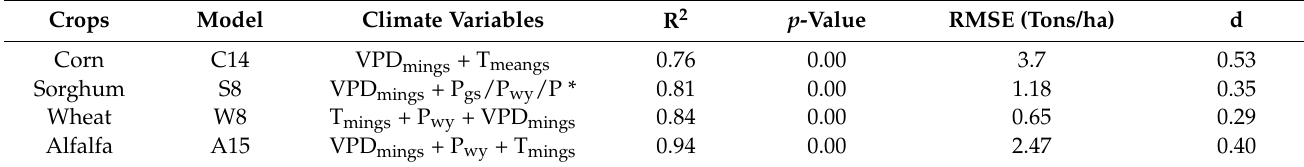
Figure 5. A summary of the correlation matrix for all 13 variables initially evaluated to predict ( a ) corn, ( b ) sorghum, ( c ) wheat, and ( d ) alfalfa yields. The matrices show the values of the Pearson’s correlation coefficient (R) with the direction and strength of correlation between all climate variables, with the positive values in blue, negative in red, − 0.25 to 0.25 in light shades of color. The correlation coefficients range from − 1 to 1, whereby − 1 means a perfect negative linear relationship between climate variables, 1 indicates a perfect positive linear relationship between variables, and 0 indicates that there is no relationship between climate variables. Color intensity is proportional to correlation coefficients. The variables on the top of each matrix were ordered using the first principal component (PC1) from high to low scores, indicated from left to right. For example, in panel c for wheat, T min had the highest score, while P wy had the lowest score in PC1. Table 3. Best regression models constructed with climate variables only